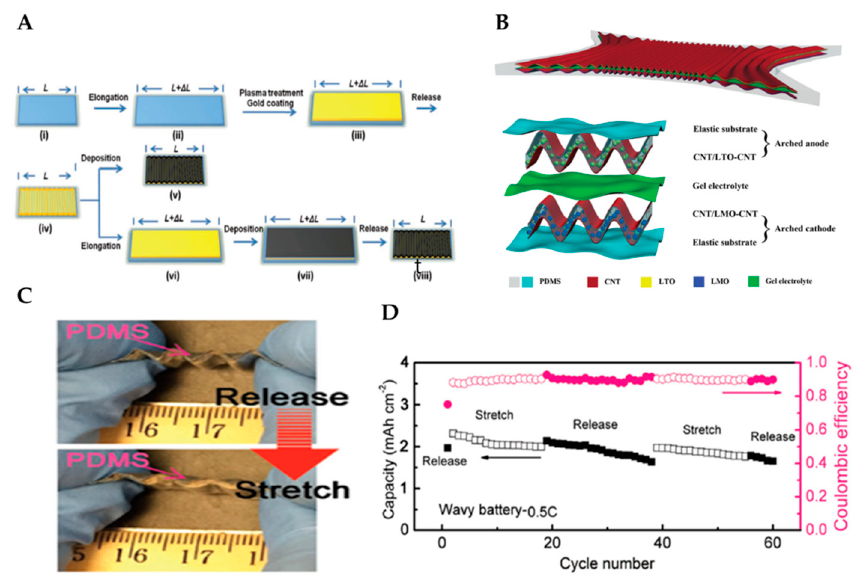
Figure 6. ( A ) Schematic procedures used to prepare buckled Au or PPy-pTS films on SIBS substrate and FESEM images of these products. Buckled PPy-pTS fabrication comprises surface treatment, Au sputter coating, relaxation of the pre-strained SIBS substrate and PPy electrodeposition. 2D buckled PPy-pTS film was electrodeposited on the re-elongated Au coated substrate, obtained after the relaxation of the substrate. Adapted with permission from [67]. Copyright (2011) WILEY-VCH Verlag GmbH and Co. KGaA, Weinheim ( B ) schematic illustration of a super-stretchy battery and its multilayered structure. Adapted with permission from [84]. Copyright (2015) Adv. Mater . Electrochemical performances at the dynamic state of the wavy battery. ( C ) Photographs showing that when stretching the wavy battery, PDMS was stretched to accommodate the deformation. ( D ) Cycling performance and Coulombic e ffi ciency for the wavy battery under releasing and stretching states (50% strain). Adapted with permission from [91]. Copyright (2017) WILEY-VCH Verlag GmbH and Co. KGaA, Weinheim